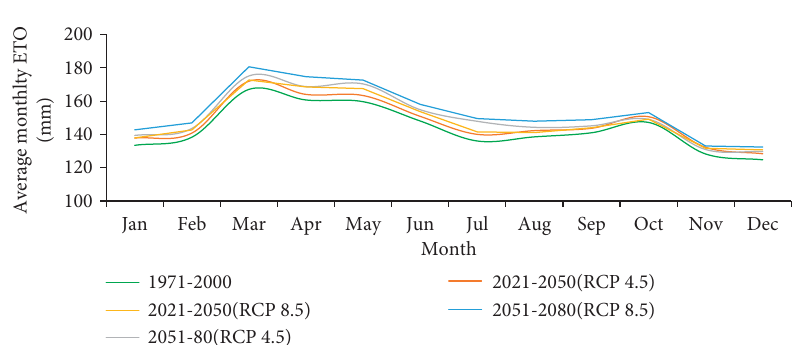
Figure 13: Changes in average monthly evapotranspiration.